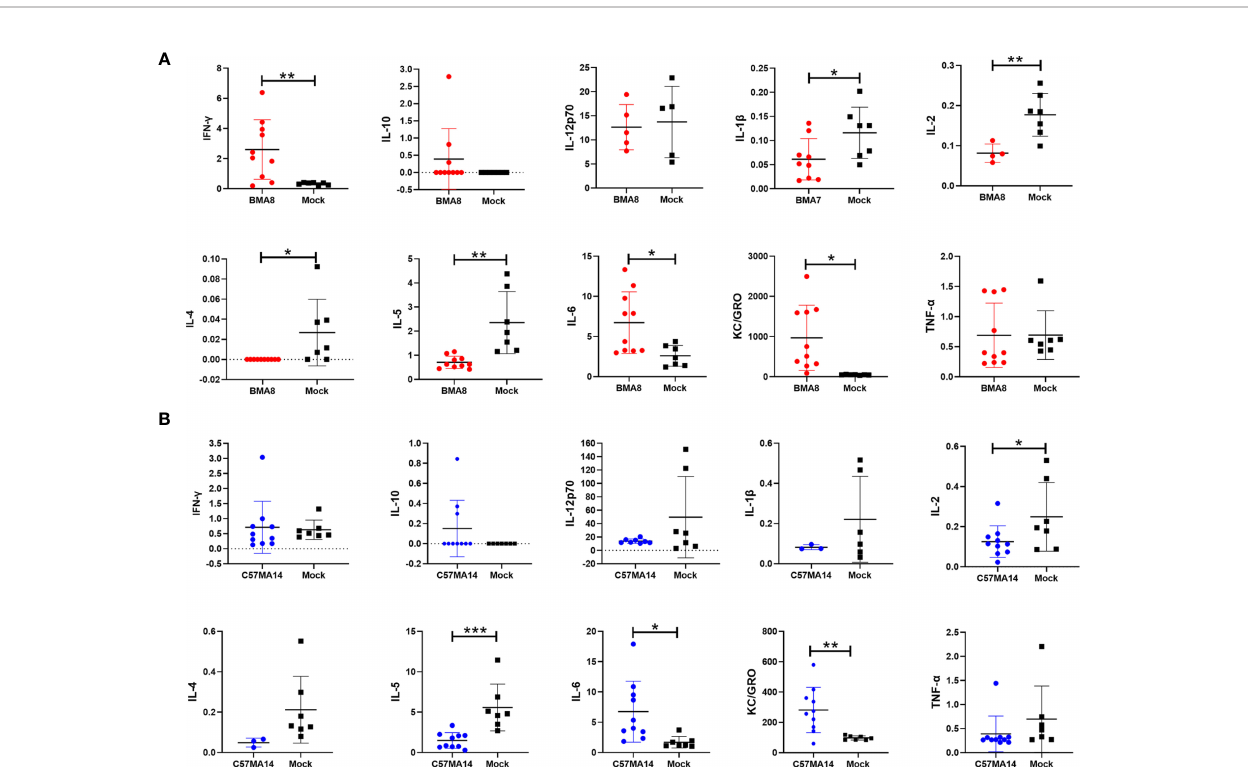
FIGURE 4 | Cytokine and chemokine production in serum of aged mice infected with the mouse-adapted severe acute respiratory syndrome 2 (SARS-CoV-2) BMA8 or C57MA14. Groups of aged BALB/c mice (n = 10) (A) or aged C57BL/6N mice (n = 10) (B) were infected with 50 LD 50 SARS-CoV-2 BMA8 or C57MA14, and the sera were harvested at 3 dpi to detect the cytokine and chemokine pro fi les in serum, respectively. Groups of aged BALB/c mice (n = 10) (A) and aged C57BL/6N mice (n = 10) (B) were intranasally inoculated with the same volume of PBS as control. Data are presented as mean ± SEM. (*P < 0.05, **P < 0.01, ***P <